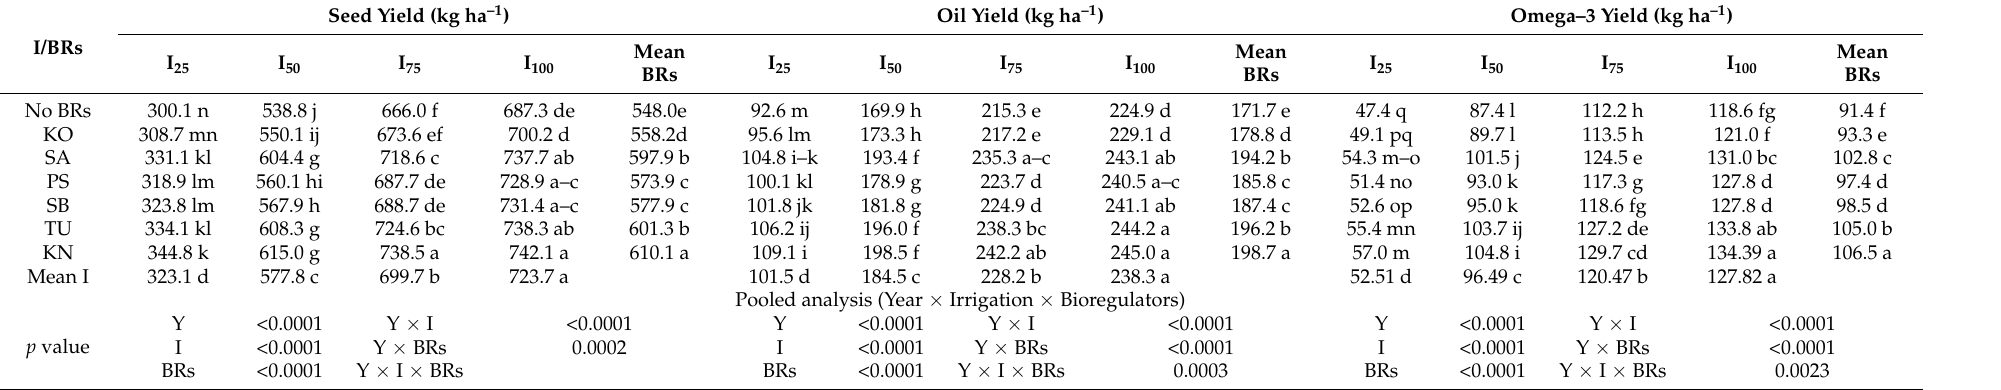
Table 2. Seed, oil, and omega–3 yield of chia as influenced by deficit irrigation regimes and